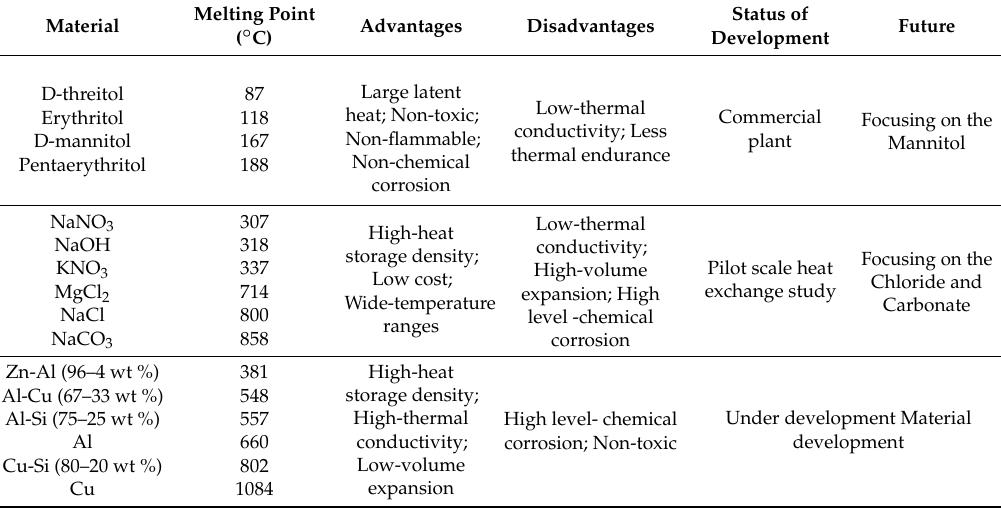
Table 7. Thermophysical properties of organic, molten salts and alloys [77].